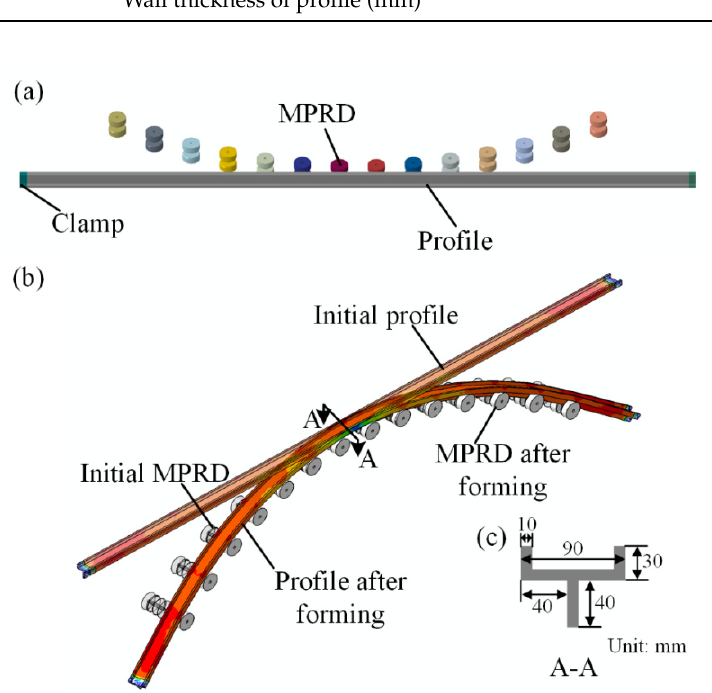
Figure 4. Finite element model. ( a ) Diagram of model assembly. ( b ) Numerical simulation results. ( c ) Cross-section of the Y-profile.